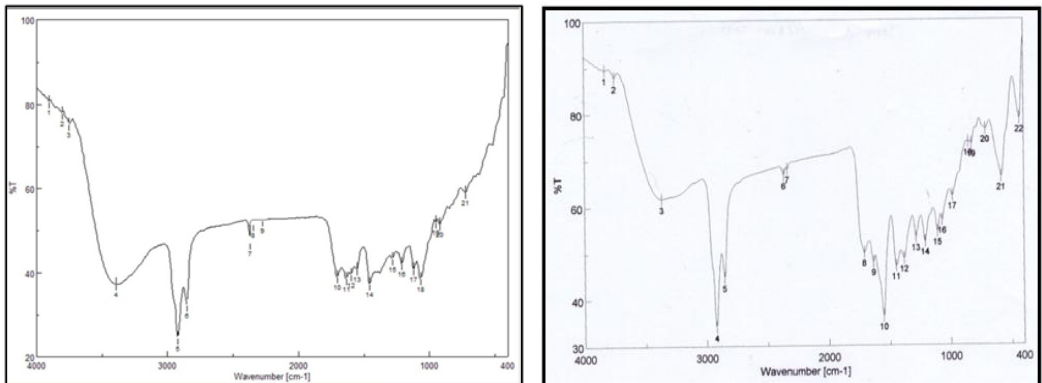
Figure 3. Infrared spectrum of Cu(II)chlorin e 4 (left) and Cu(II)chlorin e 6